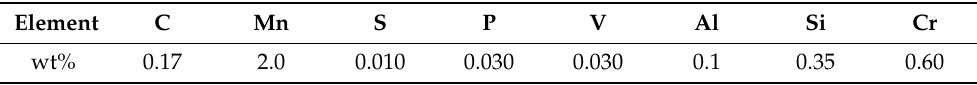
Table 1. Chemical composition of CP1000 G10/10 steel.